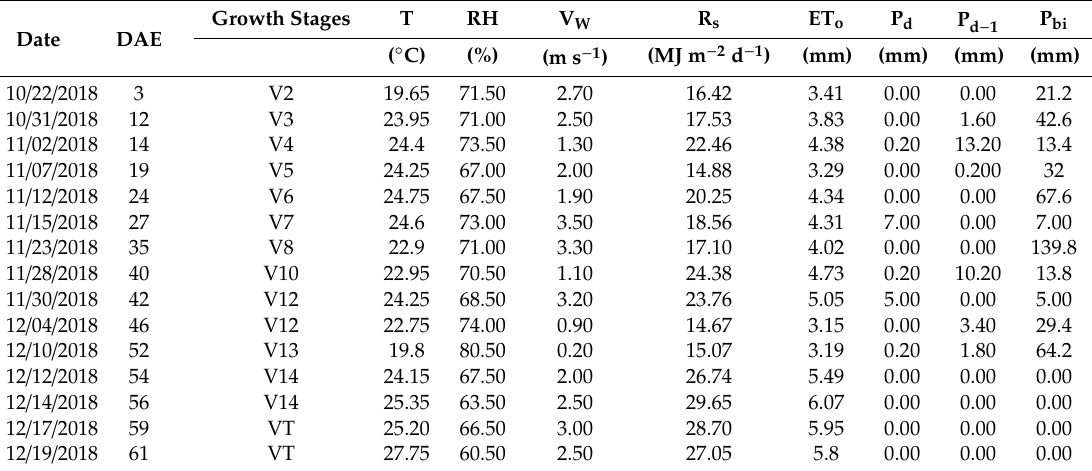
Table 1. Image acquisition dates and weather conditions at the time of